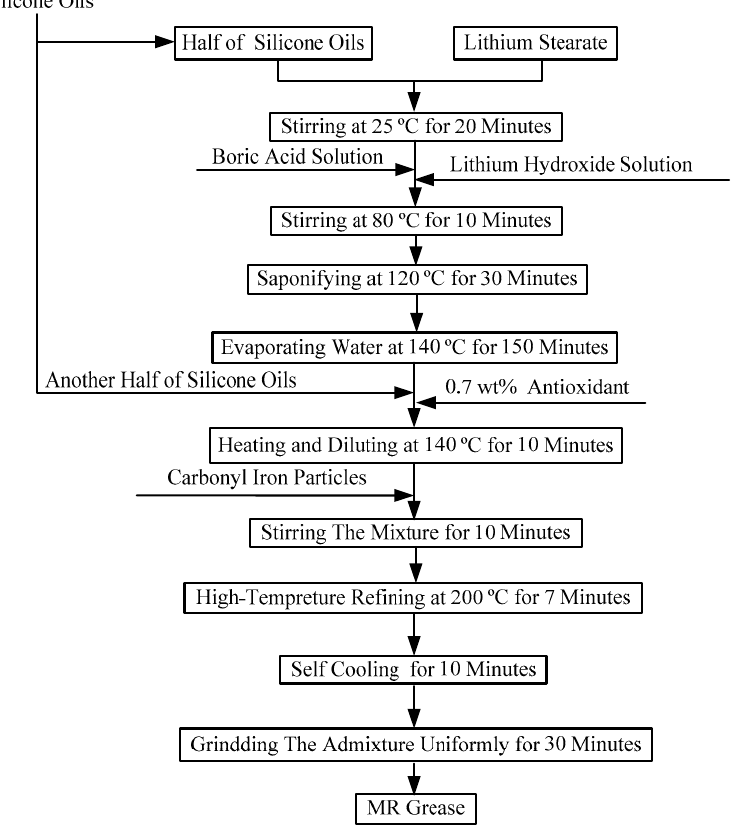
Materials 2019 , 12 , x FOR PEER REVIEW Figure 1. The preparation procedure of magnetorheological (MR) grease. Figure 1. The preparation procedure of magnetorheological (MR) grease.